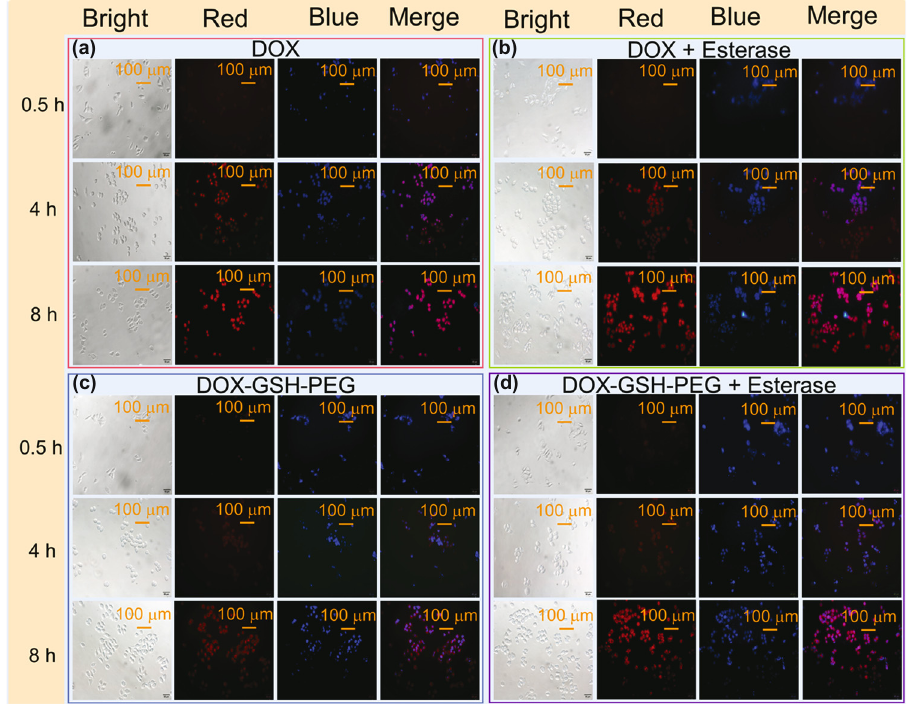
Figure 4: The distributions of ( a ) free DOX, ( b ) free DOX with esterase, ( c ) DOX - GSH - PEG and ( d ) DOX - GSH - PEG with esterase in culture media at 0.5, 4, and 8 h ( blue fl uoresce means Hoechst 33258, red fl uoresce means DOX )